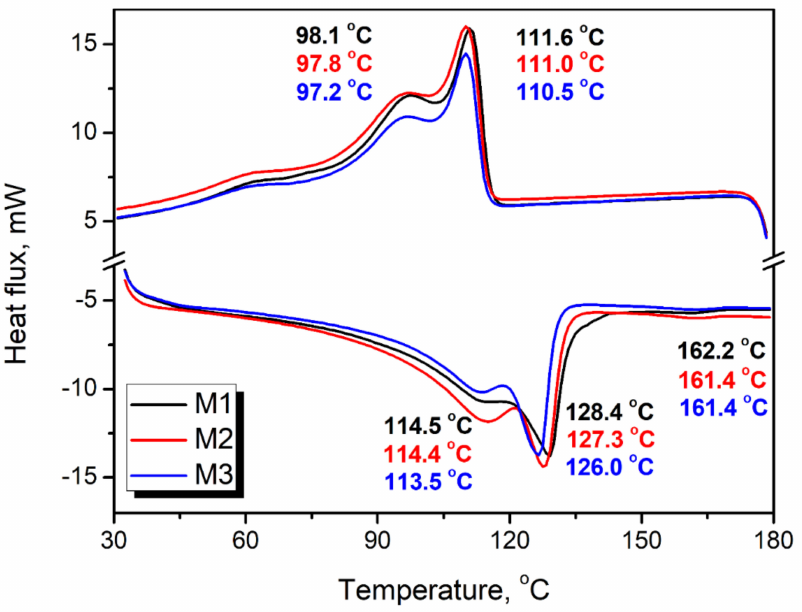
Figure 7. Cooling ( upper ) and heating ( lower ) thermograms (presented in “exo up” mode) of analyzed wastes obtained with differential scanning